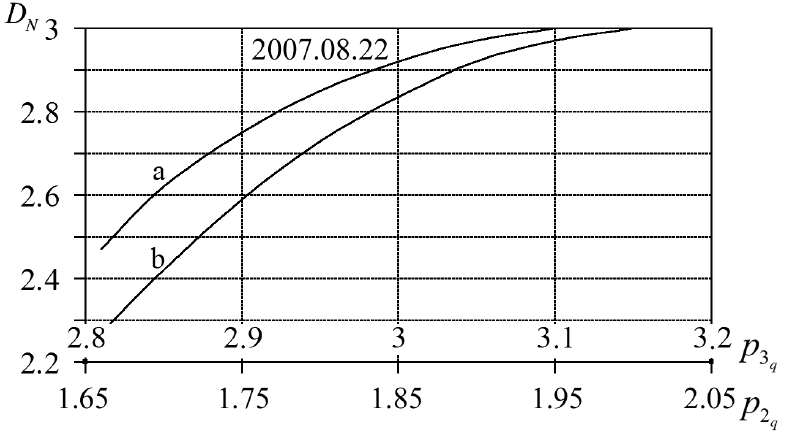
) (a) and D N ( p 3 ) (b) q q